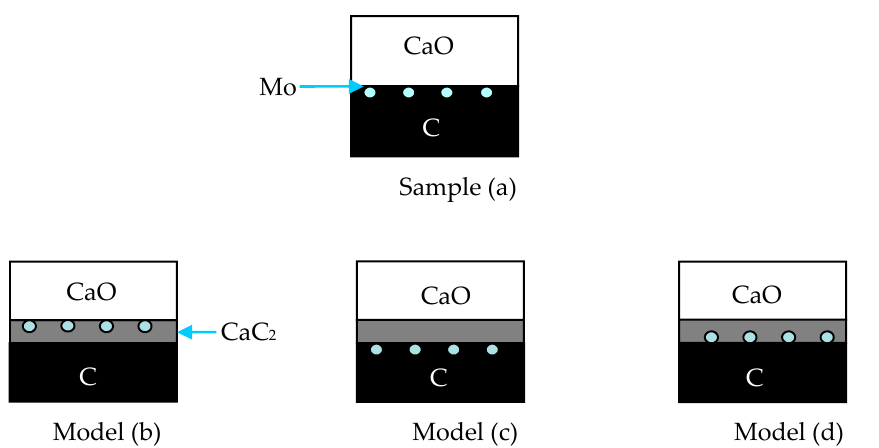
Figure 6. Diffusion models between CaO and ash–C distinguished by the Mo wires: ( a ) Sample a; ( b ) CaO diffuses into C; ( c ) C diffuses into CaO; ( d ) mutual diffusion of CaO and C.